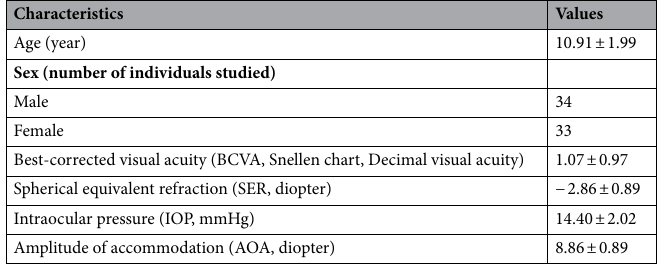
Table 1. Baseline characteristics.